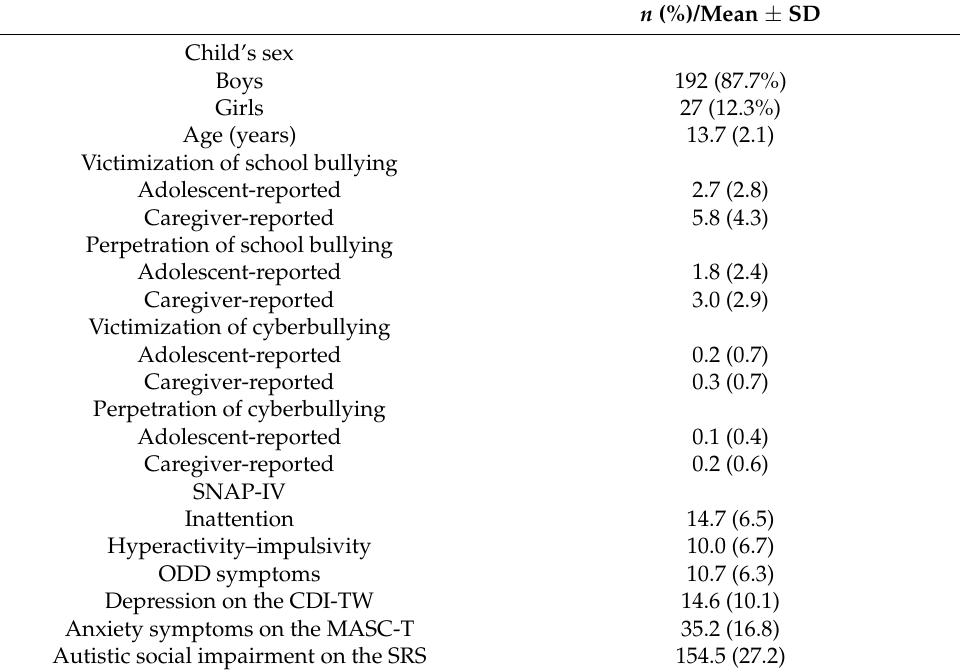
Table 1. Age, sex, bullying involvement, ADHD, ODD, depression and anxiety symptoms, and autistic social impairment of adolescents with autism spectrum disorder ( N =